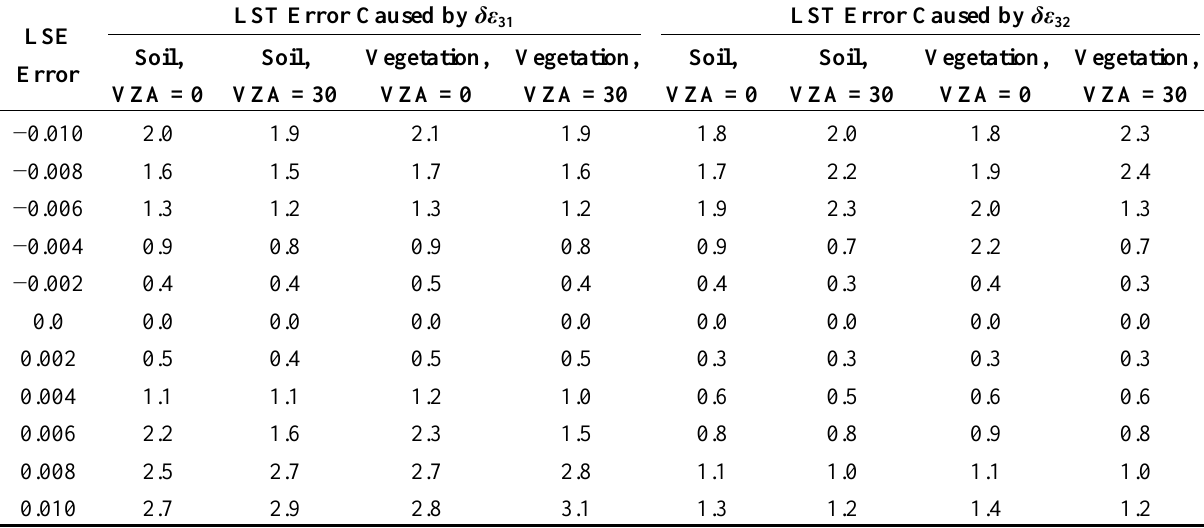
Table 7. LST error caused by errors in the LSEs of MODIS channels 31 and 32 for radiosonde profile